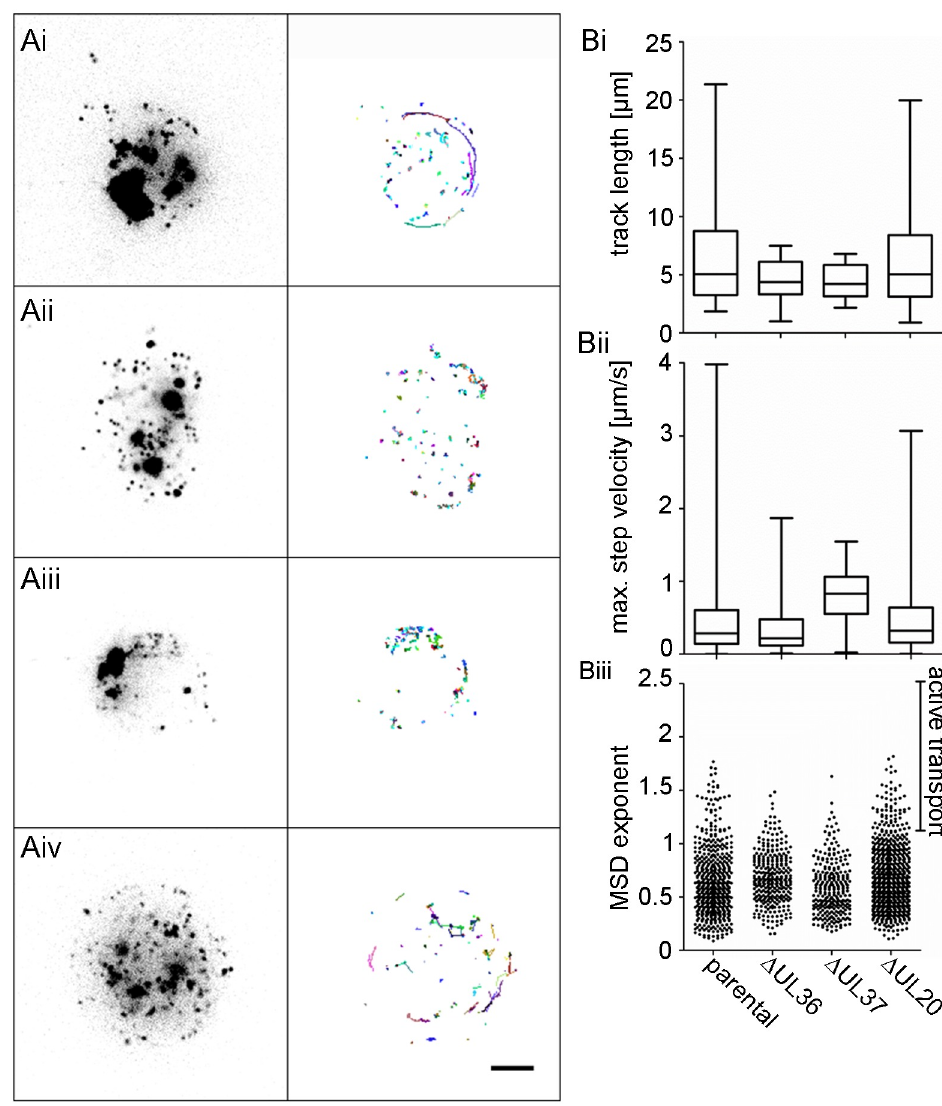
Fig 5. HSV1-pUL20 is not required for directed intracellular transport in neurons. DRG neurons infected at 5 div with 1 x 10 7 pfu/mL of HSV1(17 + )Lox-CheVP26 (Ai), - Δ UL36(Aii), - Δ UL37(Aiii), or - Δ UL20 (Aiv) and movies were acquiredbetween22 and 31 hpi. (A) Stills of movies in DRG neurons(S5–S8Movies) with representative track profiles(indicatedby a colored line and the front of each track marked by an open circle) of HSV1(17 + )Lox-mCheVP26 (i, parental),- Δ UL36(ii), - Δ UL37(iii), or - Δ UL20(iv). Scale bar, 5 μ m. (B) DRG neurons: Analysis of track profiles of HSV1(17 + )Lox-mCheVP26(parental), - Δ UL36, - Δ UL37,or -UL20. (Bi) Track lengthand (Bii) maximum step velocity of tracks with a MSD ex (cid:21) 1.2, (Biii) mean square displacement exponent(MSD ex ) with each dot representingone track. Box and whiskerswith min and